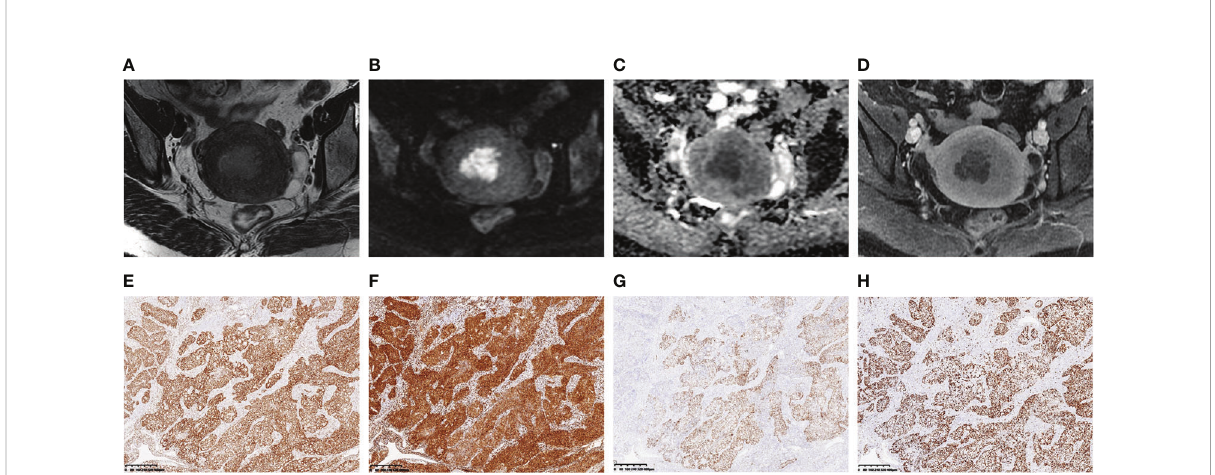
FIGURE 7 A 46-year-old woman with stage IA endometrial cancer (EC) whose main clinical complication was irregular vaginal bleeding for 3 months. The selected MR images for lesion segmentation included uterus-axial T2-weighted imaging (T2WI) (A) , diffusion-weighted imaging (DWI) (B) , apparent diffusion coef fi cient (ADC) map (C) , and late contrast-enhanced T1-weighted imaging (LCE-T1WI) (D) . The estrogen receptor (ER) (E) , progesterone receptor (PR) (F) , P53 (G) , and Ki-67 (H) immunohistochemical staining (40×) showed 90%, 90%, focal, and 80% positive cells, respectively.